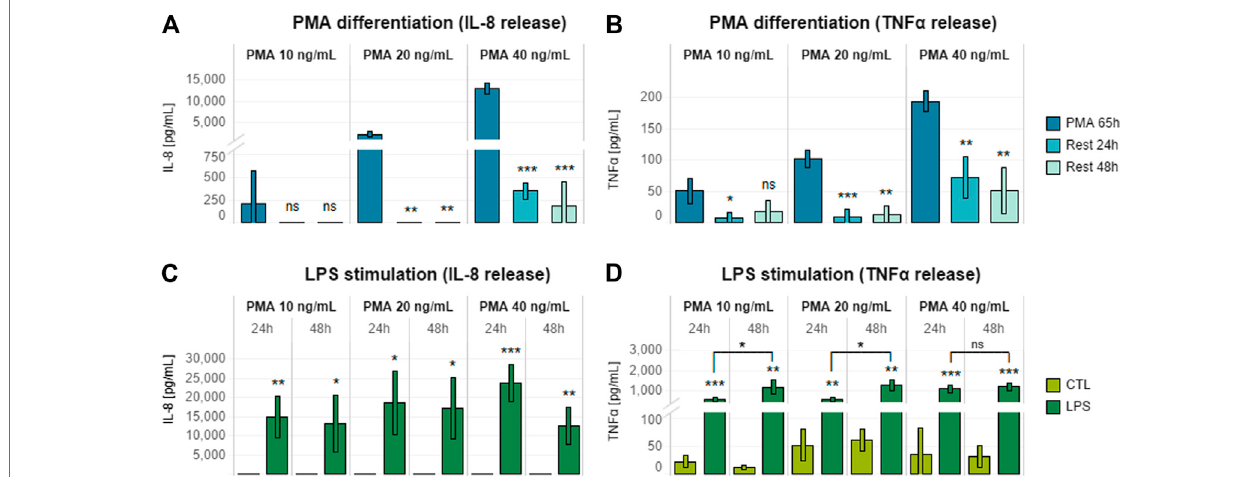
FIGURE 2 | Effects of different PMA concentrations on THP-1 post-differentiation cytokine release. (A) IL-8 and (B) TNF α release by THP-1 cells differentiated for 65 h with increasing concentrations of PMA (10, 20, and 40 ng/ml) and rested for 24 or 48 h after PMA removal. (C) IL-8 and (D) TNF α release by THP-1 cells differentiated with increasing concentrations of PMA (10, 20, and 40 ng/ml) for 65 h, rested for 24 or 48 h after PMA removal, and treated with 10 ng/ml LPS for 24 h. Data are presented as the average of three technical replicates with corresponding standard deviation. Statistical differences were calculated between the 65-h induced sample and the rested samples (A,B) or between LPS-treated and untreated cultures (C,D) by means of two-tailed t -tests. * p ≤ 0.05; ** p ≤ 0.01; *** p ≤ 0.001; ns, p > 0.05 (A,B) . Equivalence comparisons and linear regression analysis are provided in Supplementary Tables S3 and S4 . R24h (cid:2) cells rested for 24 h; R48h (cid:2) cells rested for 48 h. Abbreviations: PMA, phorbol